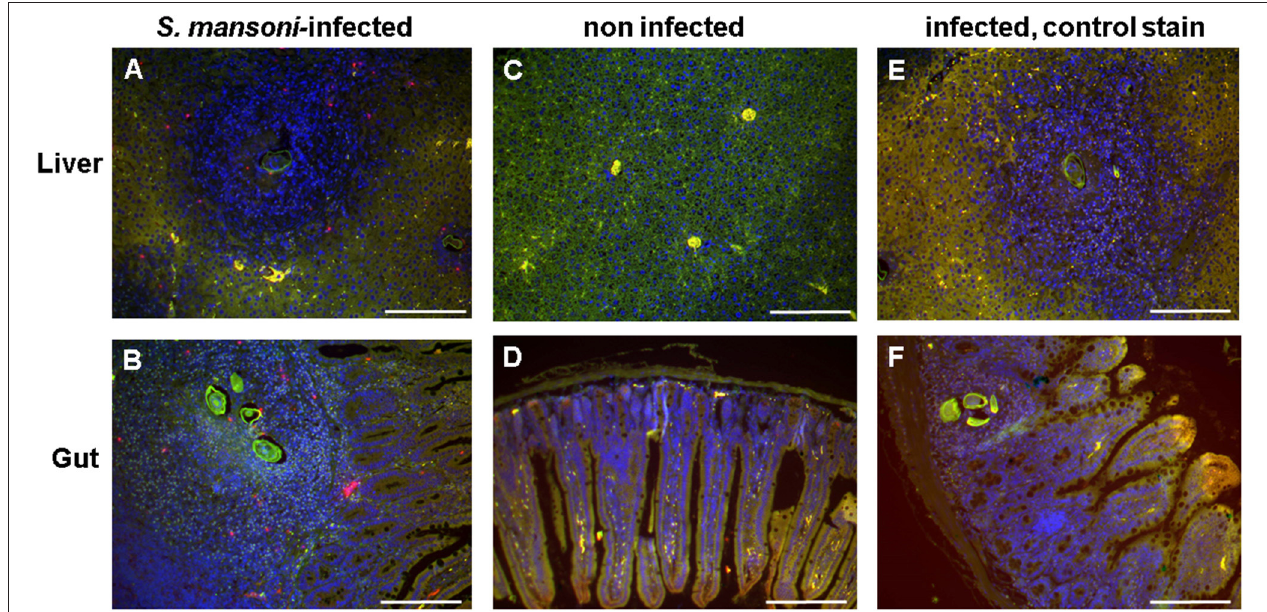
FIGURE 5 | Basophils were detected in the egg granulomas in tissue of S. mansoni -infected mice. Liver (A,C,E) and gut (ileum) (B,D,F) of S. mansoni -infected mice (A,B,E,F ) and uninfected control mice (C,D) ; Nuclei are shown stained in blue; basophils (stained in magenta) were detected exclusively in S. mansoni -infected mouse tissue, i.e., in the granulomas. Note the autofluorescence of the schistosome egg shell (green). (E,F) are negative controls without the primary antibody anti-mMCP-8. Scale bars are 200 µ